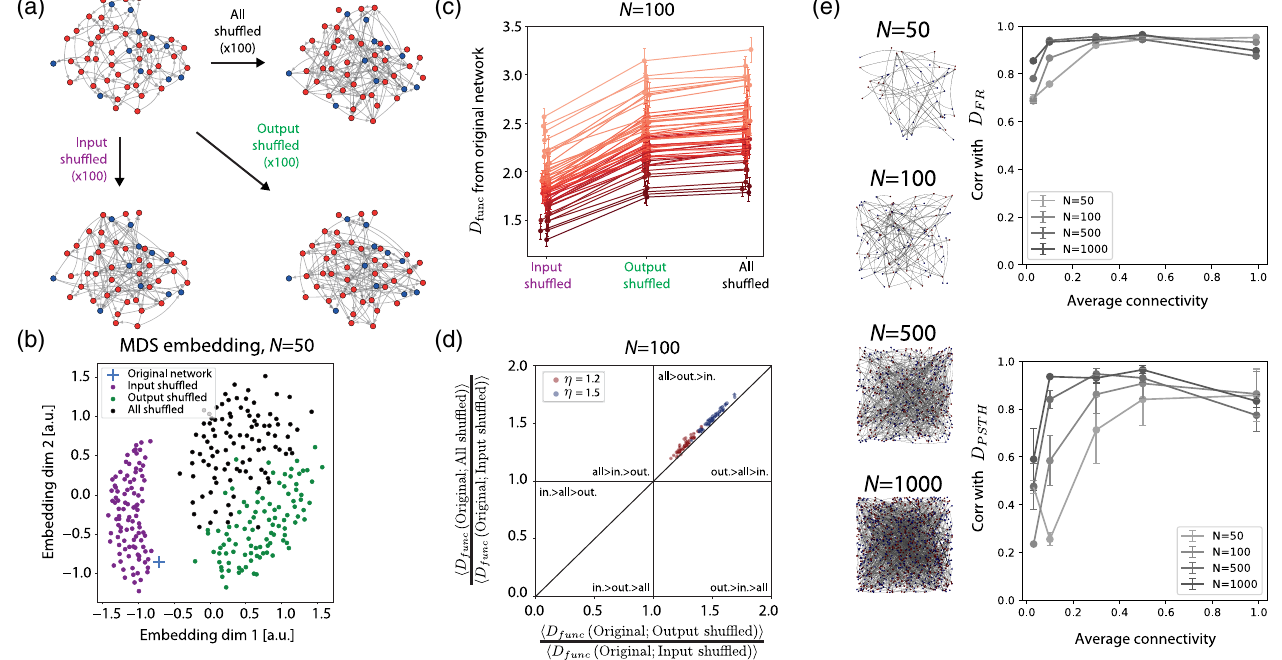
FIG. 7. The architectural features identified in small networks predict functional similarity of networks of 50, 100, and 1000 neurons. (a) We pick 100 randomly connected networks of size N ¼ 50 and N ¼ 100 and use each of these networks as a “ template. ” From each such original network, we create 100 variants preserving the sum of synaptic inputs to each neuron, by shuffling the source of the synapses into each neuron (red), 100 variants preserving the sum of synaptic outputs of each neuron, by shuffling outgoing synapses (green), and 100 variants where all synapses shuffle (black). (b) A 2D MDS embedding of one original network of 50 neurons and its 300 variants, based on their log-likelihood-based functional similarity values. (c) D between each template network of 100 neurons func and its three types of shuffled variants. Each of the 50 lines using different shades of red connects the values of the mean D between func one original template network and its 100 shuffled variants of each type. Error bars represent one standard deviation over the set of variants. (Small random horizontal jitter is added to the points for clarity.) (d) For each of the original networks, we show the ratio between its average D to all the output shuffle variants against the average of its D to all the shuffle variants, normalizing both func func values for each network by its average D to input shuffled variants. The colored dots mark the values for the networks under two func different stimuli, showing that all 100 original networks reside in the part of the “ phase space ” where their input-shuffled networks are closer to the original network than the output-shuffled ones, which are closer than the all-shuffled ones. (The relations between variants in other parts of the phase space are labeled in each of the corresponding parts of the figure.) (e) Left: examples of E - I balanced networks of 50, 100, 500, and 1000 neurons, for which we compare functional similarity measures and feature-based models. Right: The dissimilarity between networks based on the respective firing rates of the neurons in the networks (top) and by the dissimilarity of their PSTH (bottom) is presented against the prediction of the I þ O feature-based models, for different levels of sparseness of synaptic connectivity and strengths of the